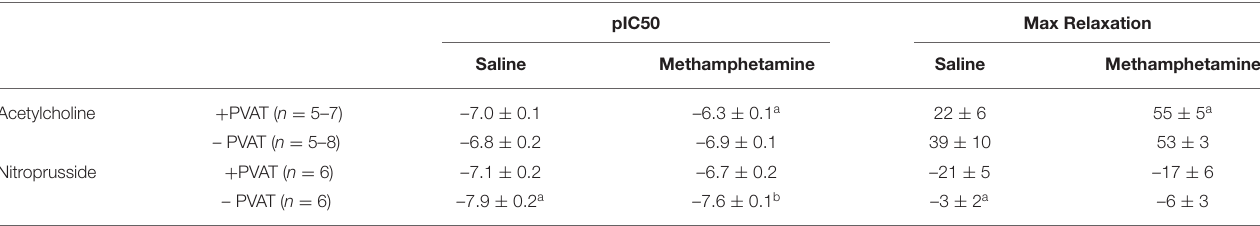
TABLE 1 | Acetylcholine- and nitroprusside-induced relaxation responses in aortas isolated from adult male rats that were exposed to fetal saline or methamphetamine (5 mg/kg/day) throughout the gestational period.